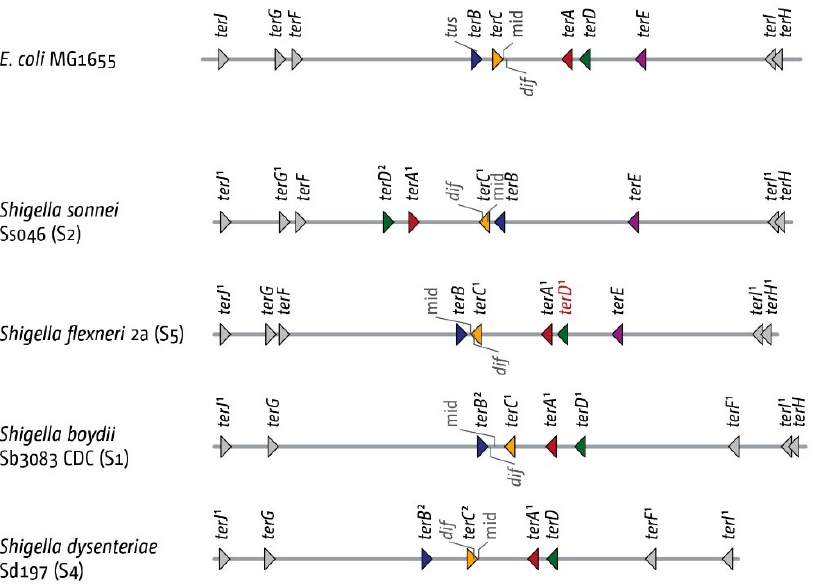
Figure 6. Architecture of the replication fork trap in genomes from four Shigella genomes representing the serotypes S1, S2, S4 and S5 (serotypes indicated in brackets behind the strain name). All ter sites identified, as well as the dif site, are indicated by markers. The orientation of the ter sites are indicated by the direction of the triangle (forks encountering the tip of the triangle would get blocked). The orientation of the dif chromosome dimer resolution site is indicated by the marker pointing upwards (indicating the (+)-strand) or downwards (indicating the ( − )-strand). If nucleotide changes occur in comparison to the MG1655 reference genome, the number of changes is shown in superscript. ter sites with changes are key residues are shown in red.